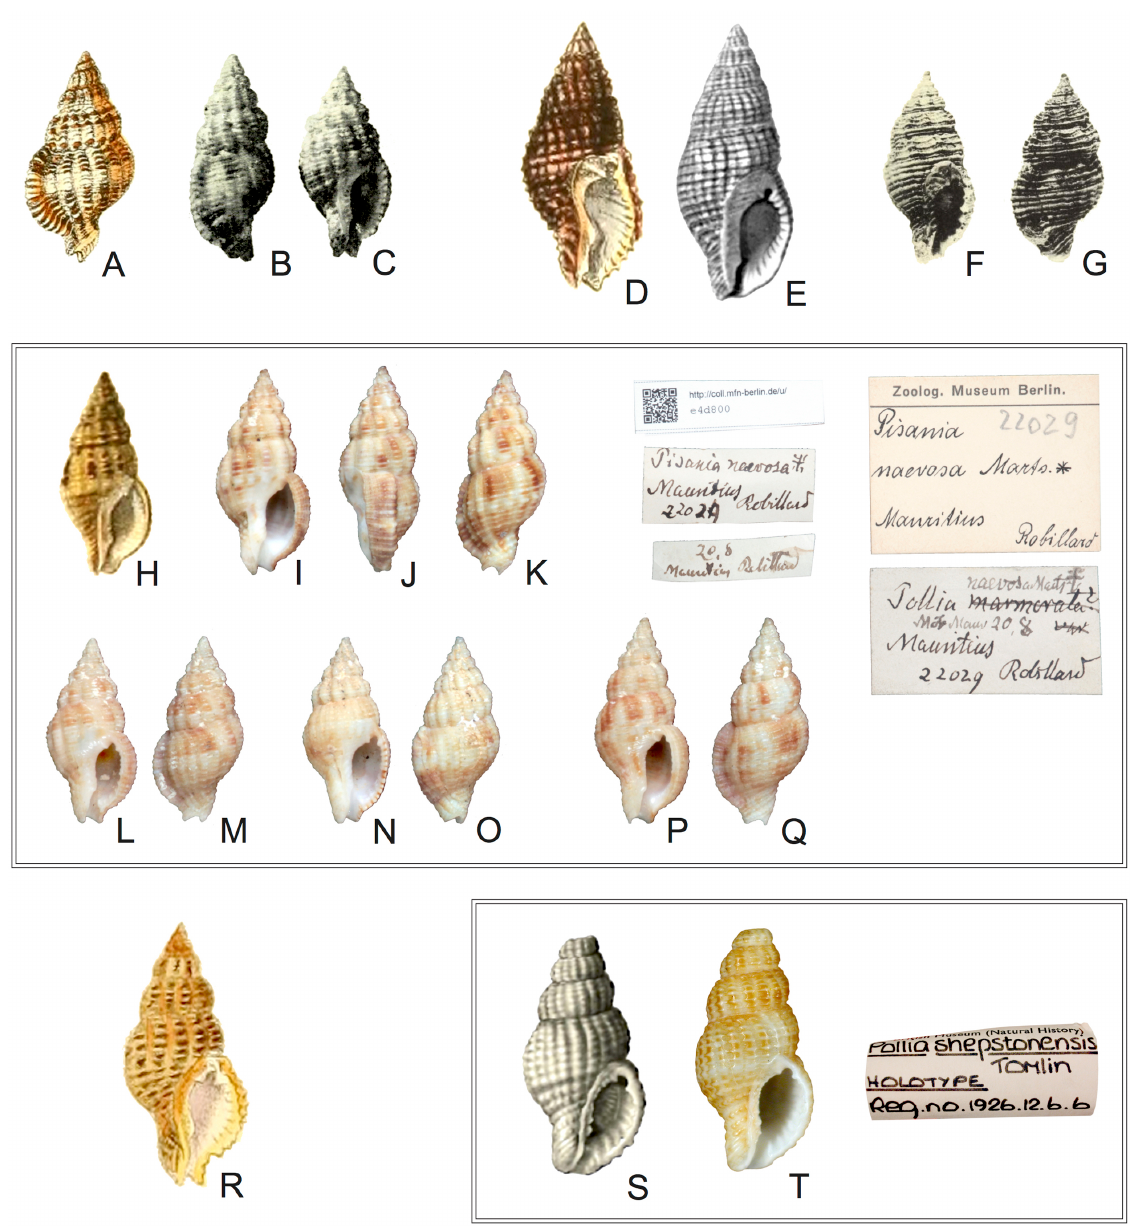
Fig. 10. Original figures and types. A . Syntype of Triton egregius Reeve, 1844, original figure taken from Reeve (1844b: pl. 18 fig. 78). B–C . Types of Phos amoenus Schwengel, 1950, taken from Schwengel (1950: pl. 5 fig. 4). B . Holotype, 15 mm long. C . Paratype, 13–14 mm long. D . Type of Buccinum cinis Reeve, 1846, original figure taken from Reeve (1846: pl. 11 no. 84). E . Syntype of Caducifer ? thaleia Pilsbry & Lowe, 1932, original figure taken from Pilsbry & Lowe (1932: pl. 6 fig. 6), 26.3 mm long. F–G . Lectotype of Hindsia angicostata Pease, 1860, taken from Kay (1965: pl. 1; figs 15–16), 15.5 mm long. H . Syntype of Pisania naevosa Martens, 1880, original figure taken from Martens (1880: pl. 20 fig. 8), 16 mm long. I–Q . Syntypes of Pisania naevosa Martens, 1880, MFN, ZMB/Moll-22029, images courtesy of Christine Zorn, Berlin. I–K . 16.3 mm long. L–M . 15.1 mm long. N–O . 14.9 mm long. P–Q . 16.3 mm long. R . Type of Buccinum nigricostatum Reeve, 1846, original figure taken from Reeve (1846: pl. 10 fig. 73). S . Holotype of Pollia shepstonensis Tomlin, 1926, original figure taken from Tomlin (1926: pl. 16 fig. 4), 24 mm long. T . Holotype of Pollia shepstonensis Tomlin, 1926, NHM(UK) 1926.12.6.6, image courtesy of Yves Terryn, 24 mm